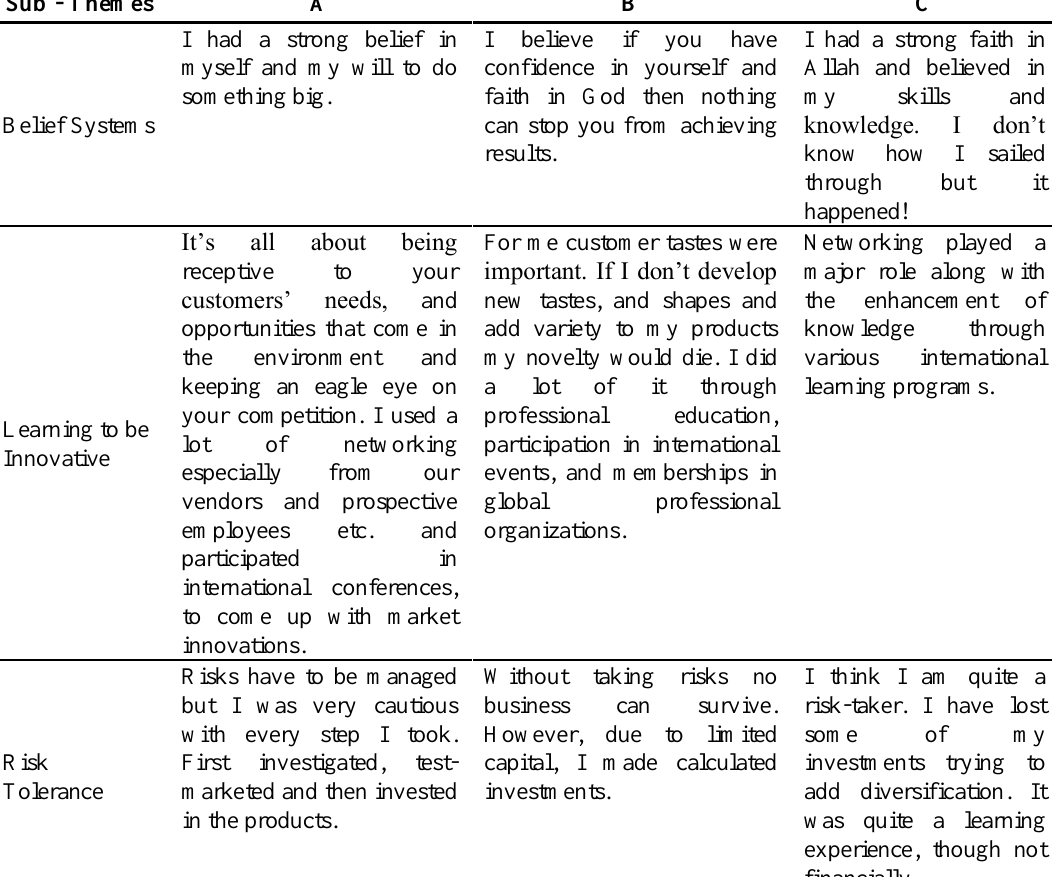
Table.3. Women’s Perception of Their Entrepreneurial